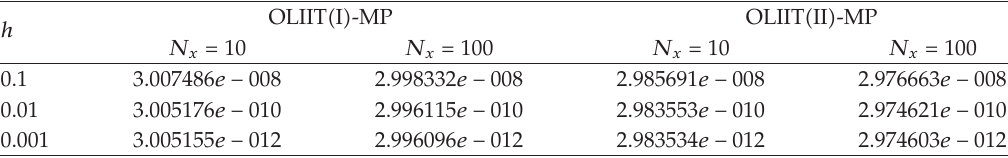
Table 8: The errors (cid:16) at t (cid:5) 10 when the algorithms are applied to the problem (cid:3) 5.6 (cid:4) with the coe ffi cients group I, where τ (cid:3) t (cid:4) (cid:5) 0 . 5 t . OLIIT (cid:3) I (cid:4)